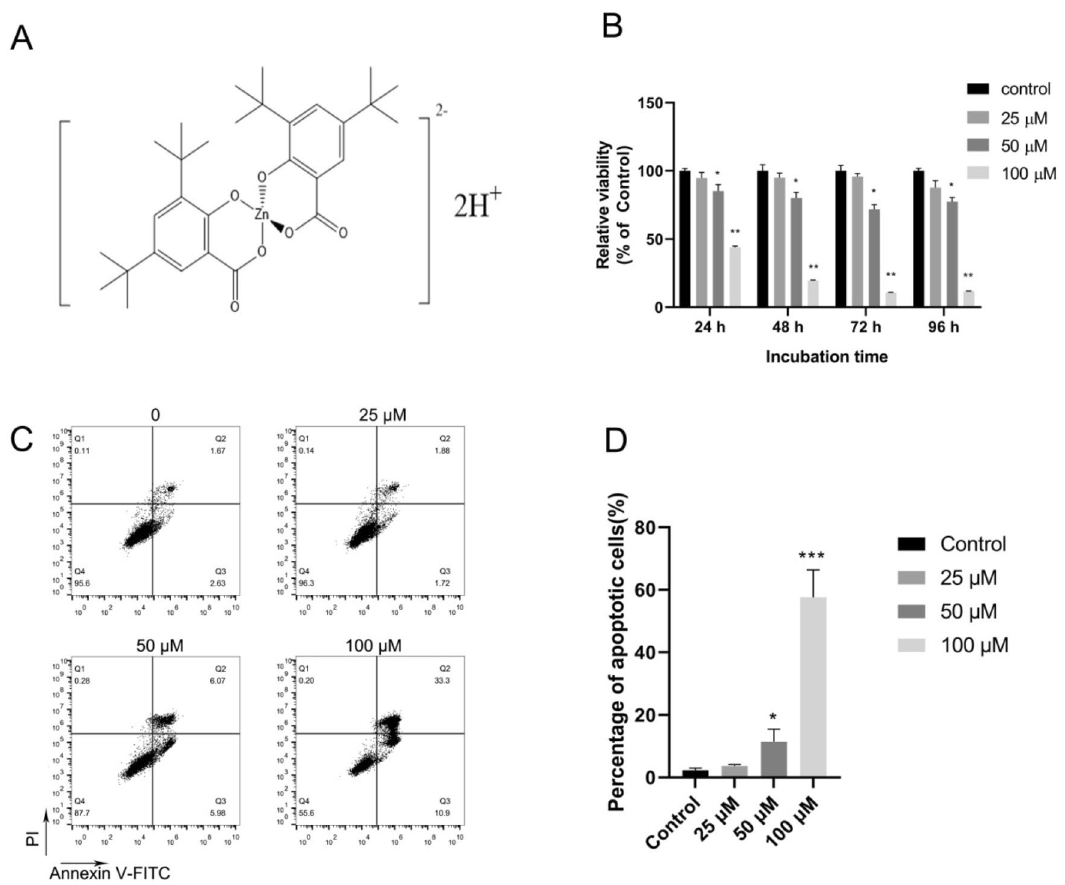
Figure 1. Zn{[CH 3 ) 3 C] 2 Sal} 2 2− inhibits cell viability and induces apoptosis of TNBC 4T1 cells. ( A ) Structure of the zinc complex of 3,5-di-tert-butyl salicylate. ( B ) Cell viability was decreased by Zn{[CH 3 ) 3 C] 2 Sal} 2 2− treatment. 4T1 cell viability was determined by MTS assay after Zn{[CH 3 ) 3 C] 2 Sal} 2 2− treatment. The statistical analysis was conducted by comparing the OD 492 value of each treatment concentration with that of the DMSO control. Error bars represent mean ± SEM. * P < 0.05, ** P < 0.01. ( C ) Zn{[CH 3 ) 3 C] 2 Sal} 2 2− induced apoptosis of 4T1 cells in a concentration-dependent manner. 4T1 cells were incubated with the indicated concentrations of Zn{[CH 3 ) 3 C] 2 Sal} 2 2− for 24 h, and apoptosis was measured by flow cytometry after staining with Annexin V-PI. ( D ) Statistical analysis of apoptosis in three independent experiments. Error bars represent mean ± SEM. * P < 0.05, *** P <